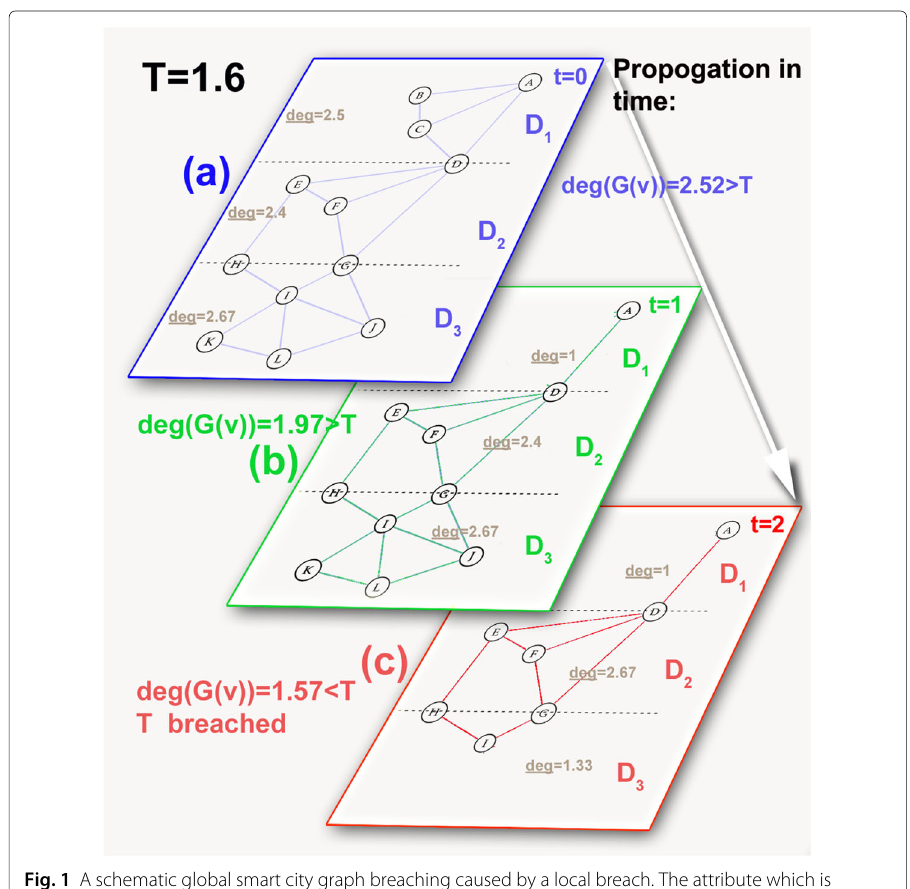
Fig. 1 A schematic global smart city graph breaching caused by a local breach. The attribute which is handled in a graph G is deg ( G ( V )) – the vertices average degree (number of edges incident to a vertex). a At some starting point t = 0 deg ( D 1 ( V )) | t = 0 = 2.5, deg ( D 2 ( V )) | t = 0 = 2.4 and deg ( D 3 ( V )) | t = 0 = 2.67,